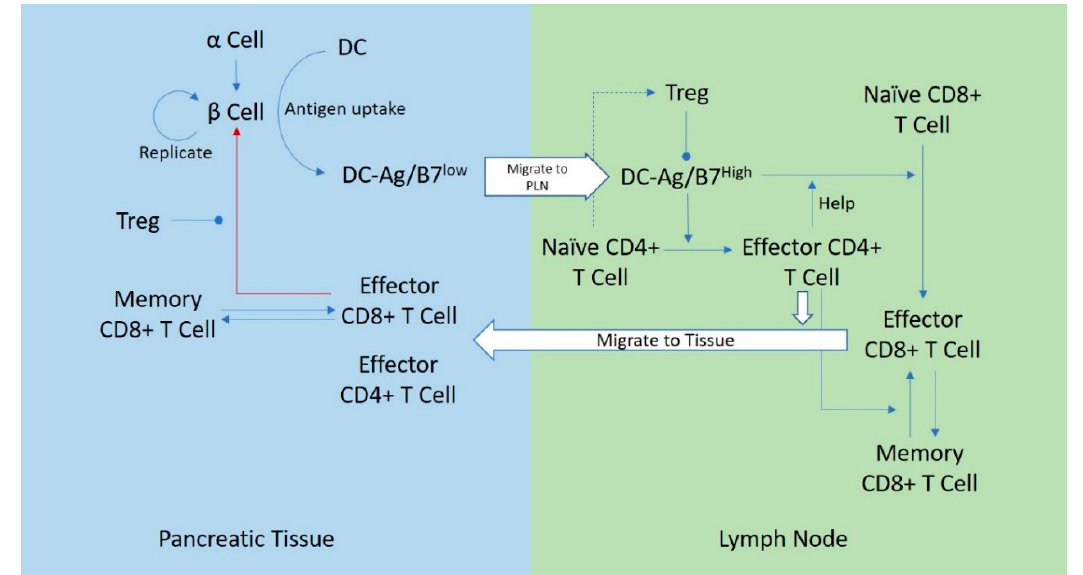
Figure 1. Islet cell arrangement in two-dimensional space grid. α cells (red circle) surround β cells (green circle) and Basement Membrane (BM) (brown dot) encloses all the cells. Islets present core- mantle structure. Color bar shows strength value of BM during disease progression during a simulation.